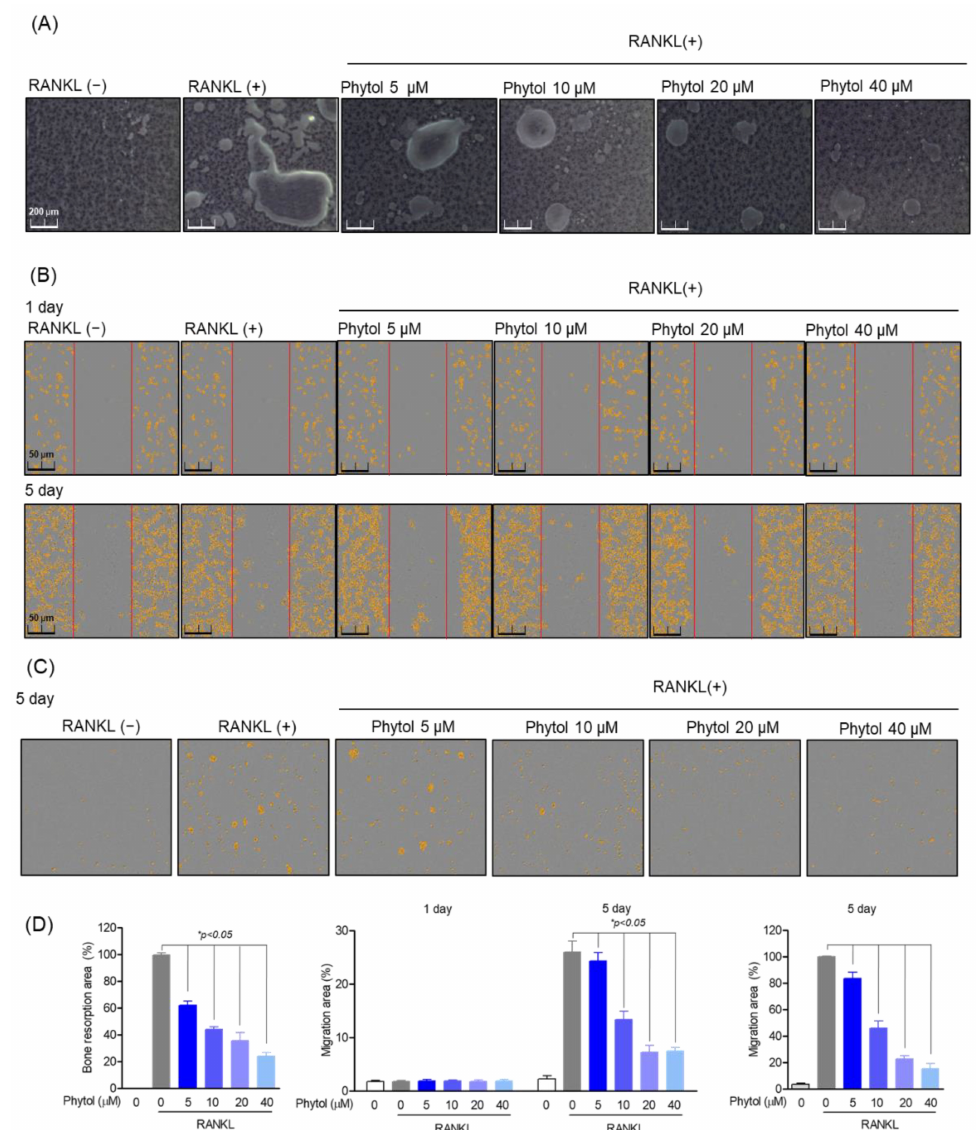
Figure 4. Inhibitory effect of phytol on receptor activator of nuclear factor kappa − B ligand (RANKL)- induced osteoclast function. ( A ) Bone resorption area after treating 5 × 10 3 cells/well with phytol at the indicated concentration for 5 days. A microscope (Olympus; Tokyo, Japan) and ImageJ program were used to measure the resorption area. ( B ) Incucyte ® Live-Cell analysis system was used to measure cell migration on day 1 and day 5 after treating cells in RANKL induced osteoclast model with phytol. ( C ) RANKL-induced osteoclast migration measurement of phytol in transwell. ( D ) Area of bone resorption and osteoclast migration. Data are presented as the mean of three independent experiments (Mean ± SD). * p < 0.05 compared to the RANKL-induced